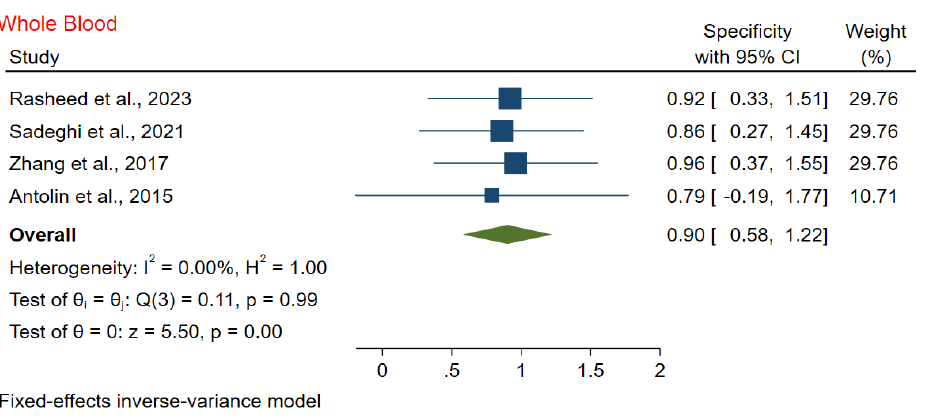
Fig. 3. Specificity of circulating microRNAs on whole blood models.